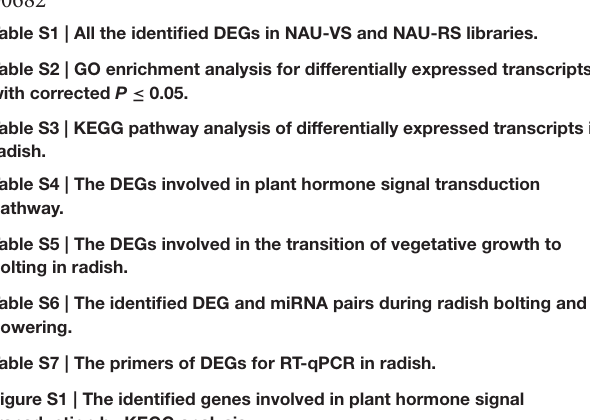
Table S1 | All the identified DEGs in NAU-VS and NAU-RS libraries. Table S2 | GO enrichment analysis for differentially expressed transcripts with corrected P ≤ 0.05. Table S3 | KEGG pathway analysis of differentially expressed transcripts in radish. Table S4 | The DEGs involved in plant hormone signal transduction pathway. Table S5 | The DEGs involved in the transition of vegetative growth to bolting in radish. Table S6 | The identified DEG and miRNA pairs during radish bolting and flowering. Table S7 | The primers of DEGs for RT-qPCR in radish. Figure S1 | The identified genes involved in plant hormone signal transduction by KEGG